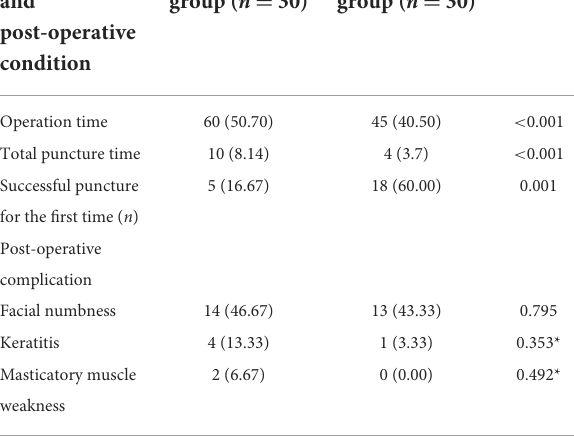
TABLE 2 The intraoperative and post-operative situation of C-arm X-ray group and laser navigation group. Intraoperative